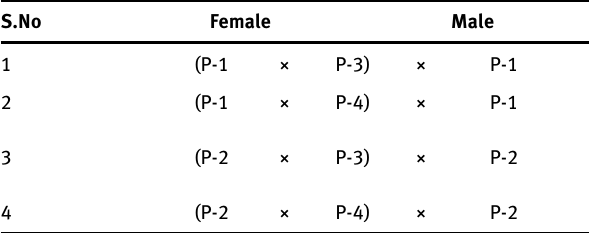
Table 4: BC2 Generations S.No